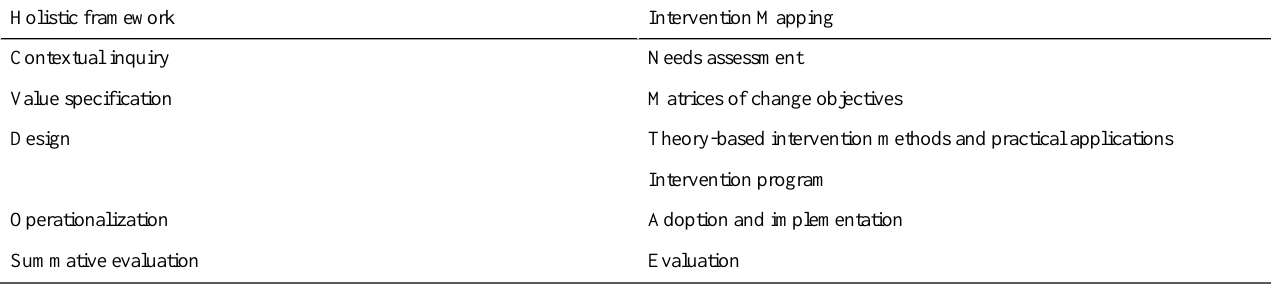
Table 1. Activities in the holistic framework and steps within Intervention Mapping